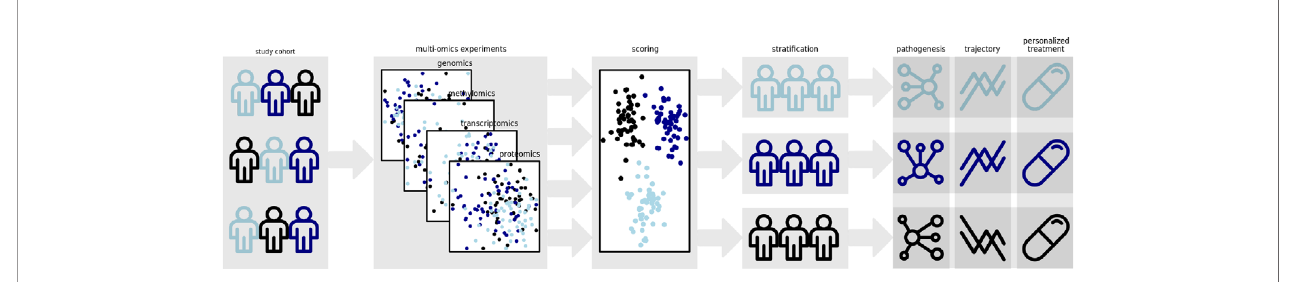
FIGURE 1 | Polygenic risk scores represent promising tools for the strati fi cation of patient groups. Incorporation of additional data from methomics, transcriptomics and proteomics experiments might enable the derivation of multidimensional scoring schemes allowing a more accurate clustering of molecular disease phenotypes. The identi fi cation of these disease subtypes might enable the elucidation of distinct disease pathogeneses and trajectories. Ultimately, it will allow custom strategies for care and treatment of the individual patient.